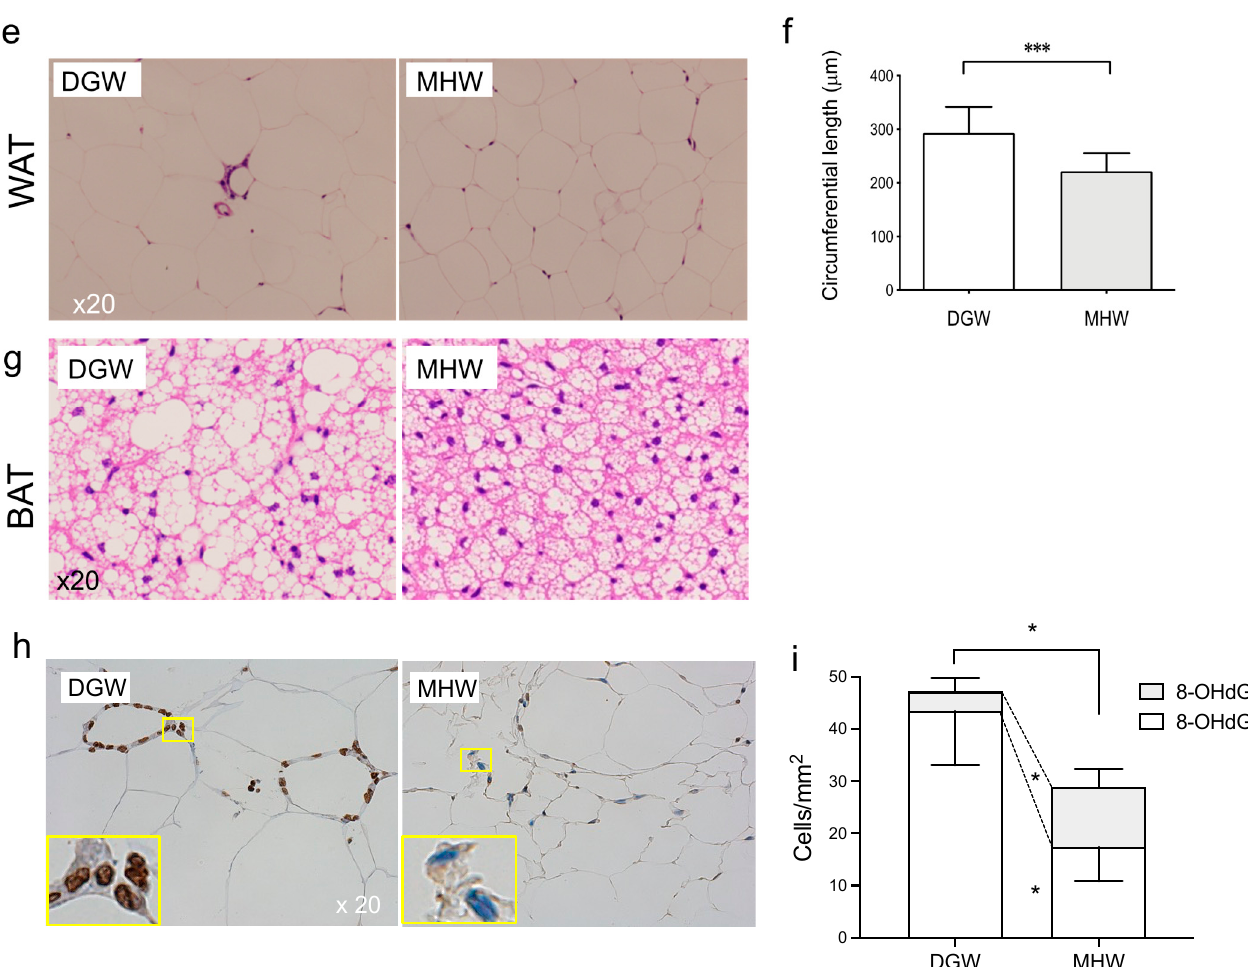
Figure 3. The features of WAT and BAT in DIO mice after treatment with MHW vs. DGW for 2 weeks. The representative features of adipose tissue masses of WAT ( a ) and BAT ( c ) in DIO mice treated with MHW or DGW. The percentages of WAT ( b ) or BAT ( d ) per kg BW in DIO mice treated with either MHW or DGW. n = 7 or 8; ** p < 0.01; ns, not significant. ( e ) Representative H&E-stained images of WAT adipocytes in DIO mice treated with either MHW or DGW. ( f ) The average circumferential length of WAT adipocytes in the MHW and DGW groups. n = 6; *** p < 0.001. ( g ) Representative H&E-stained images of BAT in the DGW and MHW groups; ns, not significant; n = 6; *** p < 0.001. ( h ) Hematoxylin and 8-OHdG-stained features of WAT in MHW- or DGW-treated DIO mice. The image surrounded with a yellow line in the DGW or MHW panels is magnified in each image in the yellow-framed insert at the bottom left corner. The double-stained (dark brown) and hematoxylin-stained (blue) nuclei indicate the 8-OHdG+ and 8-OHdG- cells. ( i ) 8 ‐ OHdG+ and 8 ‐ OHdG ‐ cell densities in WAT of the MHW and DGW groups; n = 4; * p < 0.05.